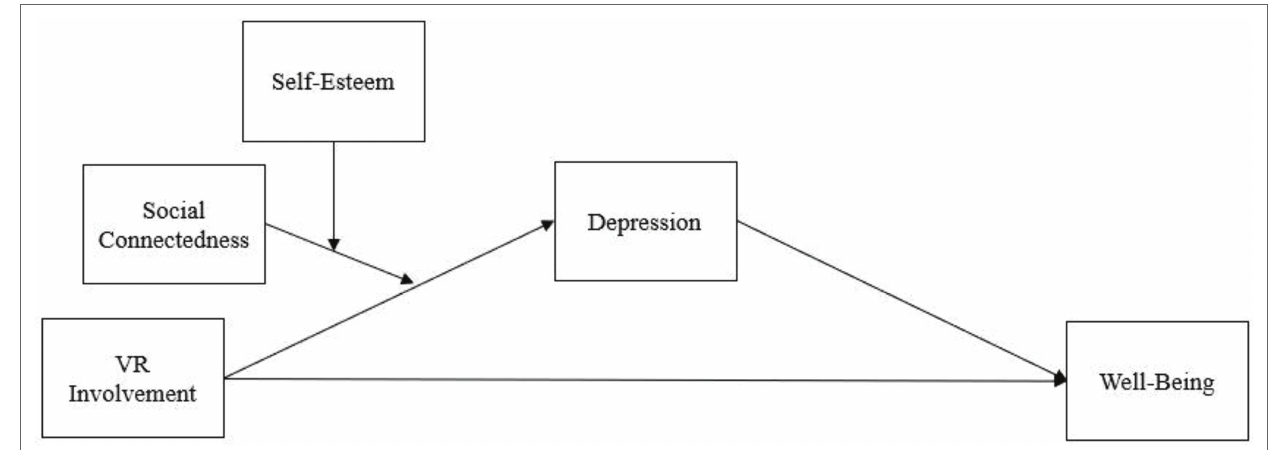
FIGURE 1 | Research